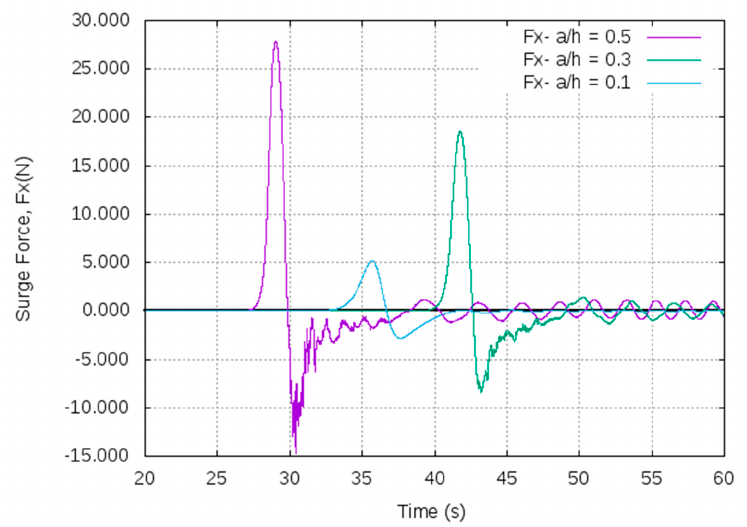
Figure 15. Surge or longitudinal force experienced by the pontoon while encountering solitary wave (OW3D, a / h = 0.1, 0.3, and 0.5).